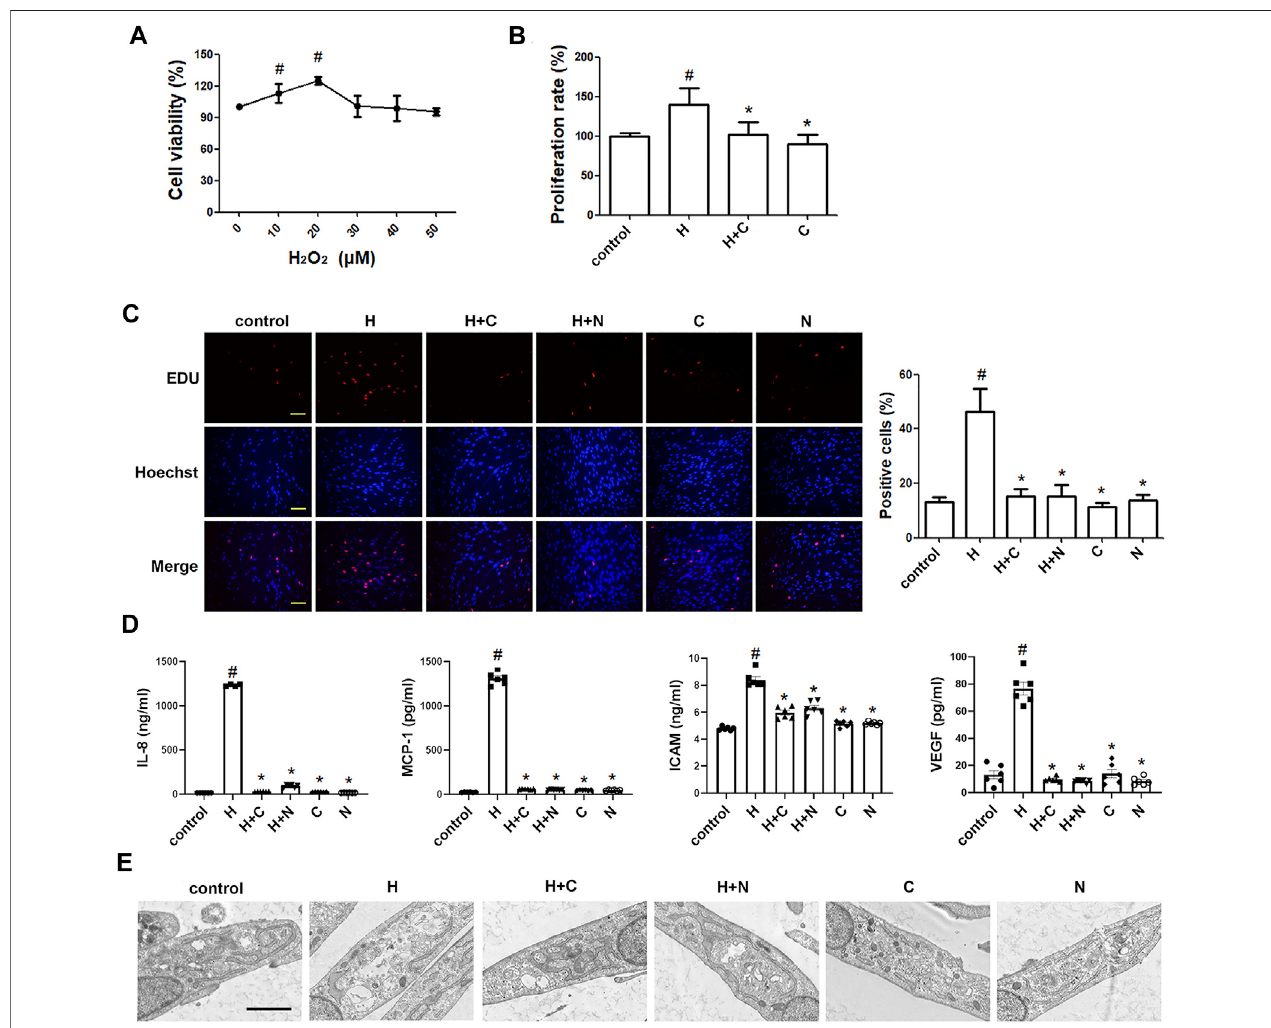
FIGURE 5 | Treatment with chloroquine inhibited the H2O2-induced proliferation, hypersecretion and hypertrophy in ASM cells (A) Effect of stimulation with different concentrations of H2O2 on the proliferation of human ASM cells as assessed by CCK-8 assay (B) Effect of chloroquine on H2O2-stimulated human ASM cells as assessed by CCK-8 assay (C) Effect of chloroquine on H2O2-stimulated human ASM cells as assessed by EdU assay (magni fi cation, ×200; scale bar, 100 µm) (D) The IL-8, MCP-1, ICAM-1, and VEGF levels in the supernatant were measured by ELISA (E) Effect of chloroquine on H2O2-stimulated human ASM cells as assessed by TEM (magni fi cation, ×7000; scale bar, 2 µm). Values are the mean ± SEM of at least four independent experiments performed in triplicate. # p < 0.05 compared with the control, and * p < 0.05 compared with the TGF- β 1 group. C, chloroquine (5 μ m); H, H2O2 (20 μ m); N, NAC (10